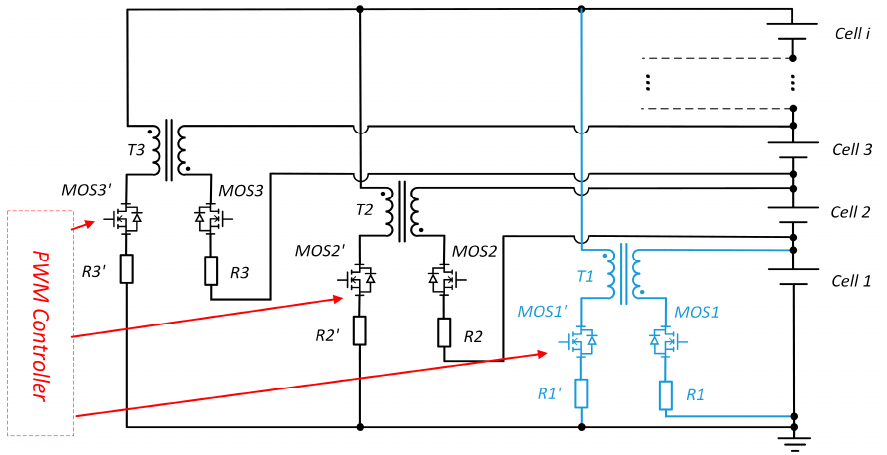
Figure 2. The architecture of a bidirectional flyback transformer equalizer (BFTE).